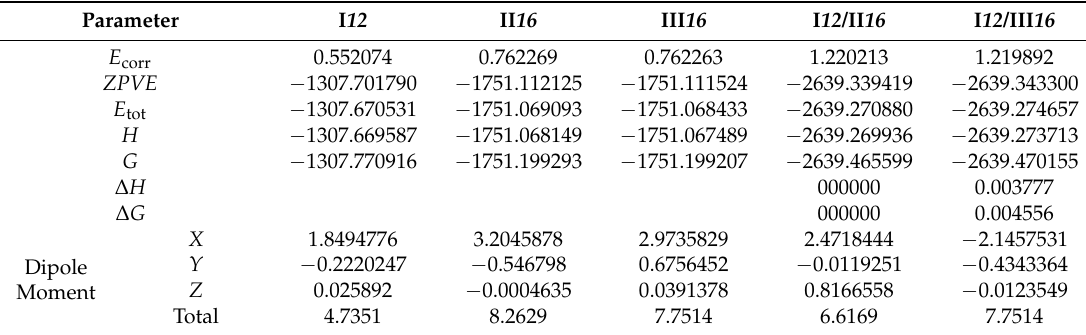
Table 2. Thermal parameters (Hartree/Particle) and dipole moment